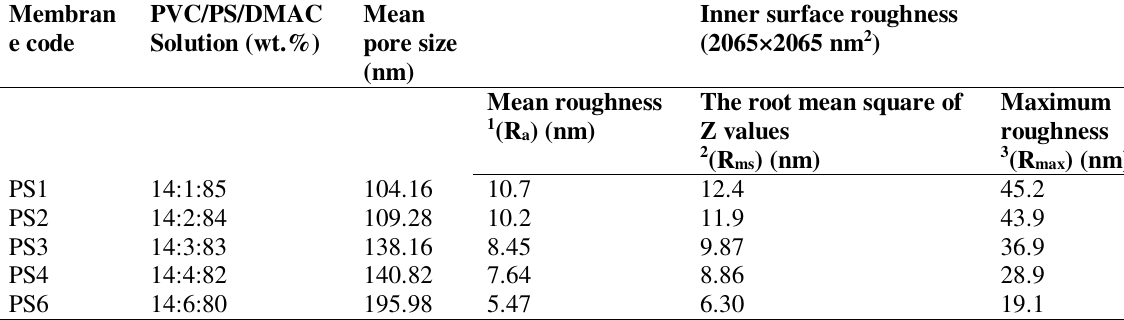
Table 1, Mean pore size and mean roughness of the inner surface of the hollow fiber blend membranes Membran e code